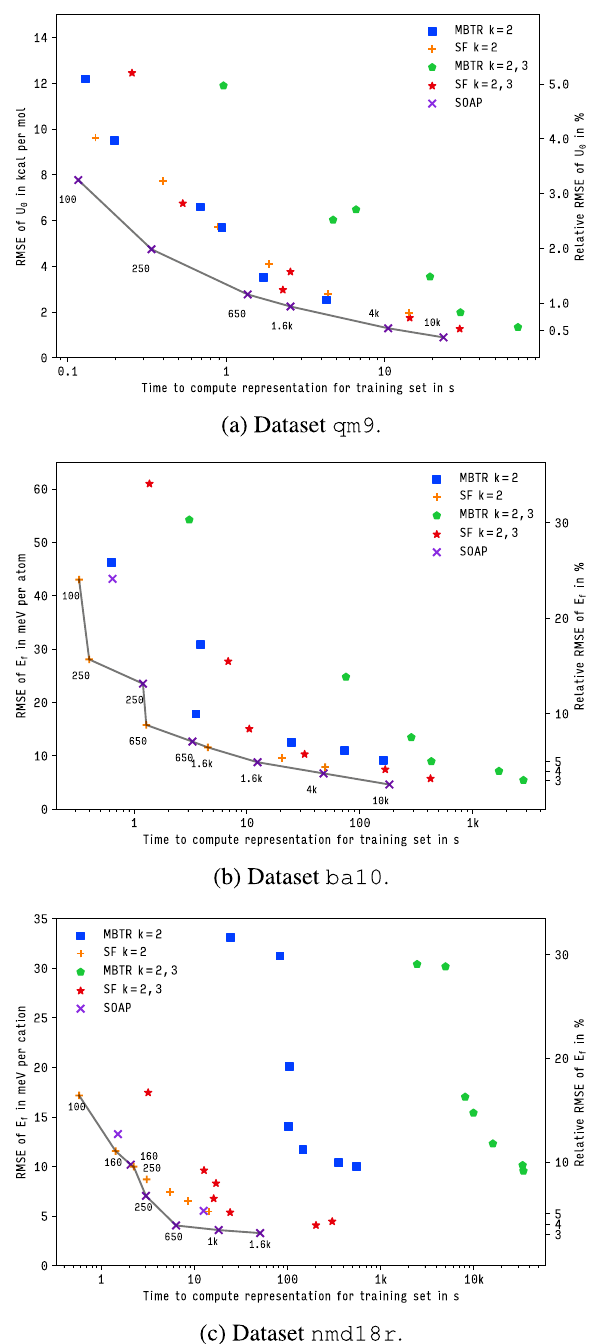
Fig. 6 Compute times of selected representations for datasets. Datasets a qm9, b ba10, and c nmd18r. Shown is root mean squared error (RMSE) of energy predictions on out-of-sample-data as a function of the time needed to compute all representations in a training set. Lines indicate Pareto frontiers; inset numbers show training set sizes. See Glossary (Table 1) for